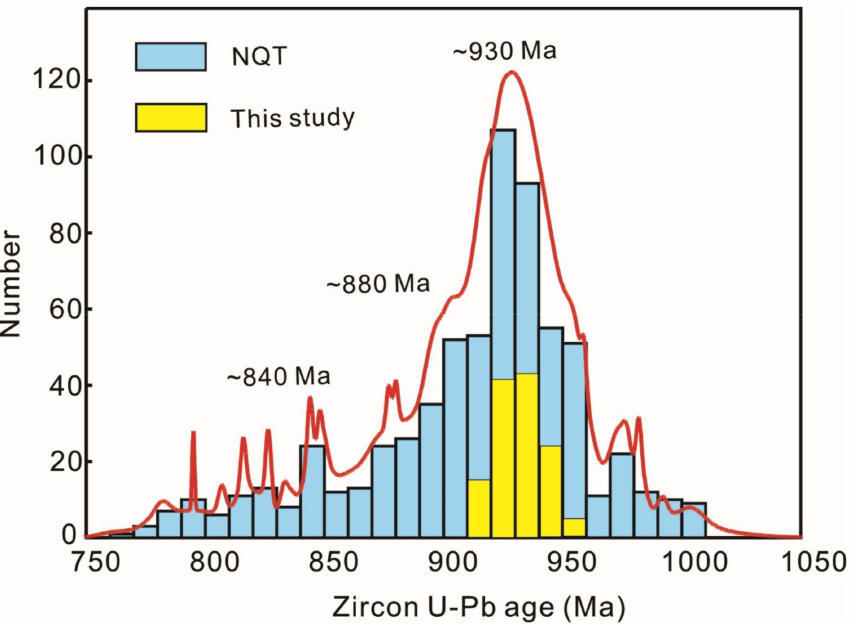
Figure 10. U–Pb zircon age histogram with a probability density plot for Neoproterozoic granitic rocks from the NQT. Data sources for the eastern part of the NQT: [18–20,30,32–34,36,37,39–42,51,52]. As inherited zircon cores represent restite of granitic rock sources in the deep conti- nental crust, their ages are important for determining the nature of the sources. The large contribution (Figure 7g,h) of Paleo- to Mesoproterozoic (ca. 1.9–1.0 Ga) inherited zircon ages identified in the Xinyang granitic gneiss samples indicates that their protoliths were derived from Paleo- to Mesoproterozoic